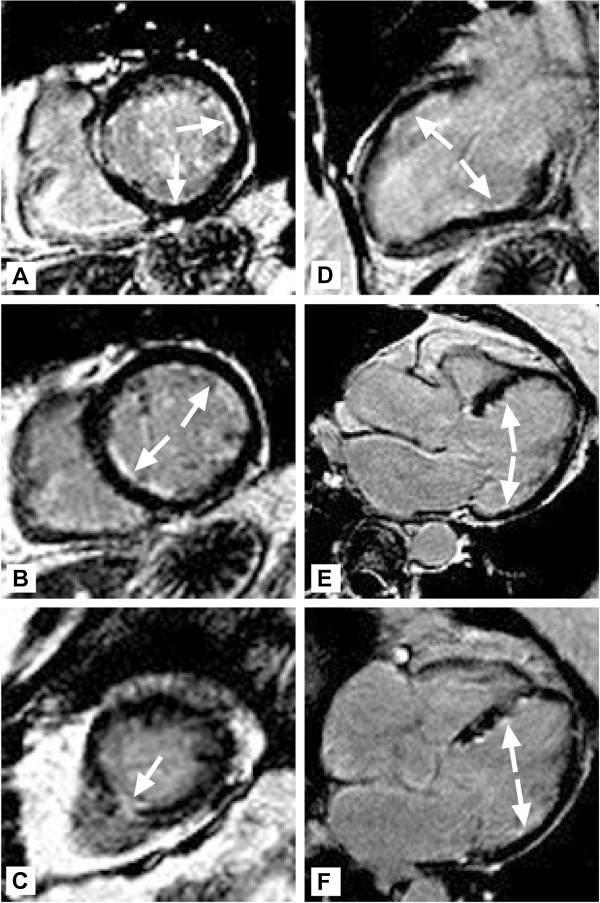
Panels A-F Cardiac Magnetic Resonance Imaging–Phase sensitive inversion recovery gadolinium delayed enhancement images through the left ventricle are shown in short axis planes (A-C): basal, mid and apical cross-sections, and in long axis planes (D-E): 2-chamber view showing the anterior and inferior walls, 3-chamber showing the antero-septal and infero-lateral walls and 4-chamber showing the infero-septal and antero-lateral walls. Normal myocardial signal is nulled and therefore appears black. The white arrows point to the multi-territorial regions of shallow subendocardial hyperenhancement; C–also demonstrates a focus of more transmural inferoapical involvement. Features are in keeping with hypereosinophilic endomyocarditis.